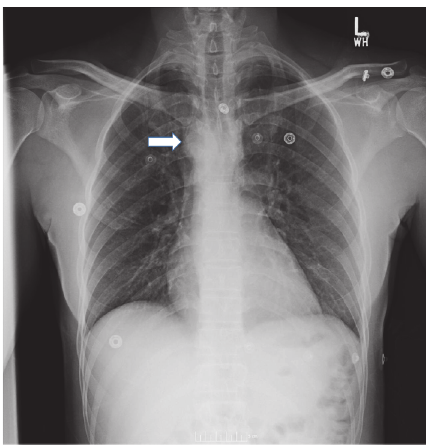
Figure 1: Radiograph of the chest posteroanterior view, with the right sided aortic arch (white arrow).